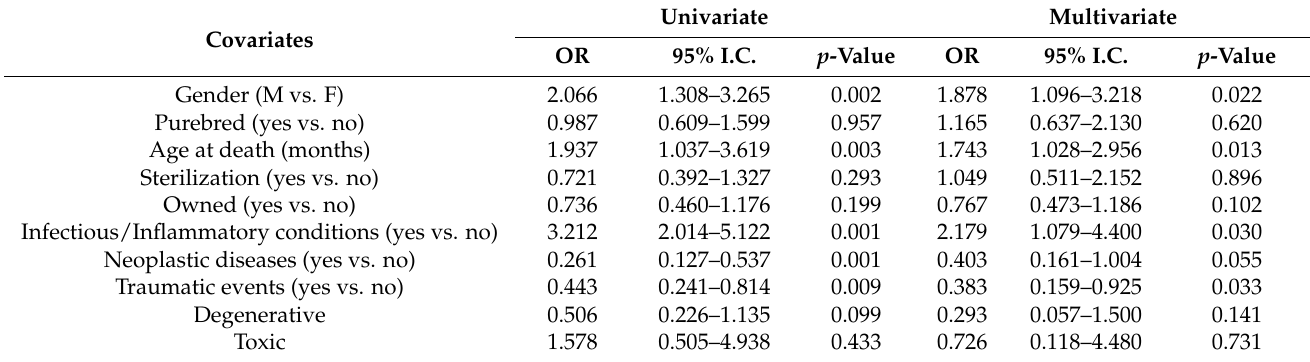
Table 3. Results of univariate and multivariate logistic regression analysis for gender, purebred, age at death, sterilization, owned and PPs as risk factors associated with “Unassisted death (yes or